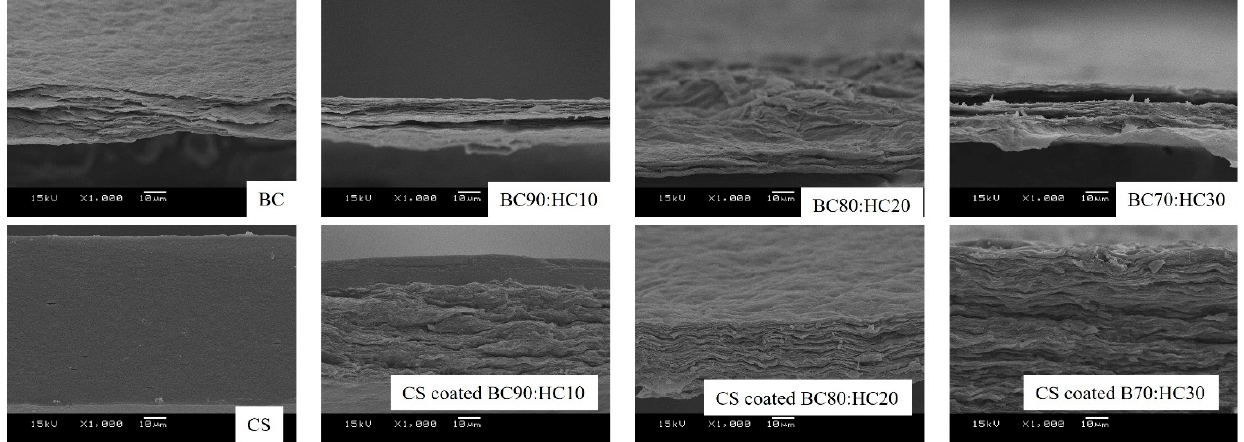
Figure 3. Cross ‐ sectional SEM images of BC, CS, BC90:HC10, BC80:HC20, BC70:HC30, CS ‐ coated